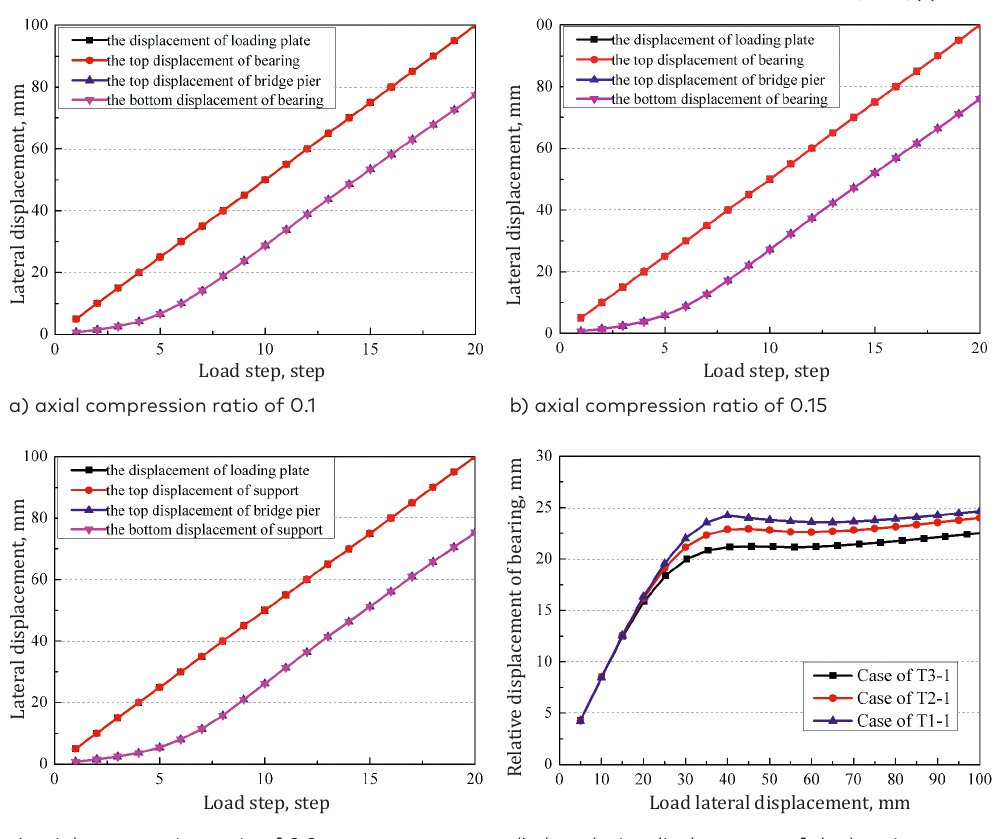
c) axial compression ratio of Figure 2. Lateral displacement of the series system under anchor connection at both ends of the bearing